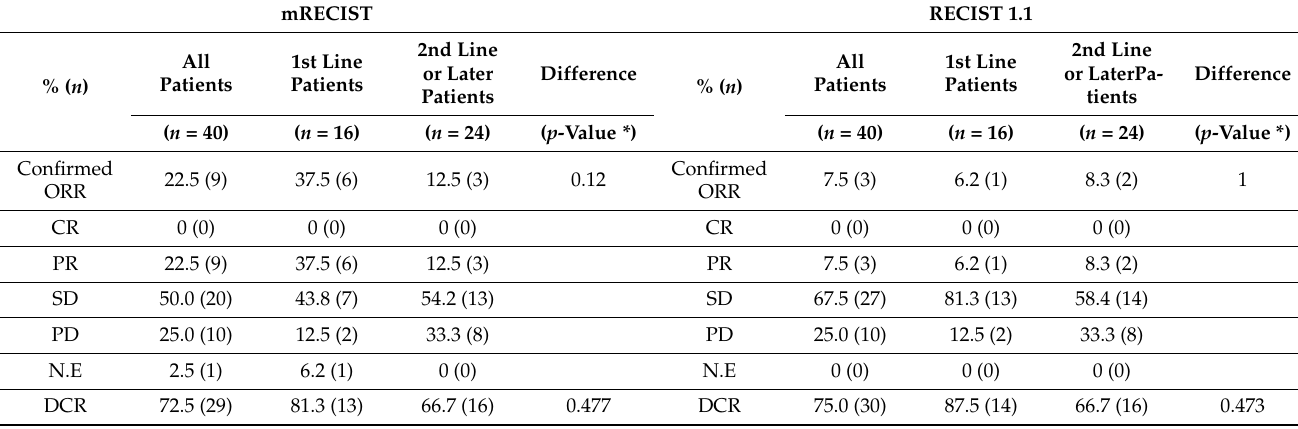
Table 3. Tumor responses at first evaluation based on mRECIST and RECIST 1.1 guideline. mRECIST RECIST 1.1